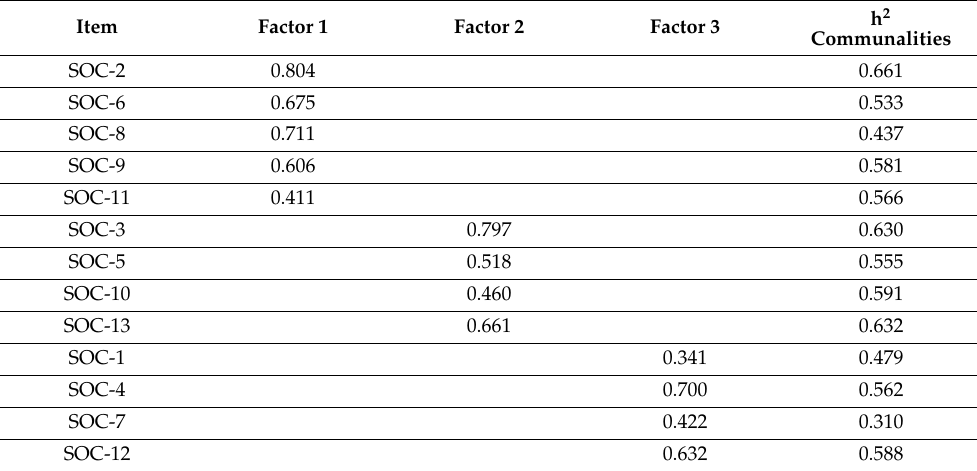
Table 2. Exploratory Factor Analysis using a principal axis analysis with oblique (direct oblimin) rotation of the SOC-13 scale (Colombian